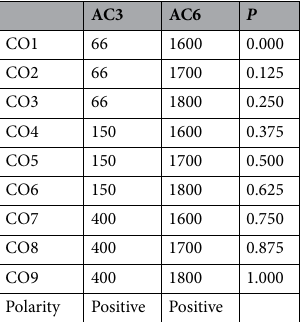
Table 8. Complete rule base for criteria AC3 and